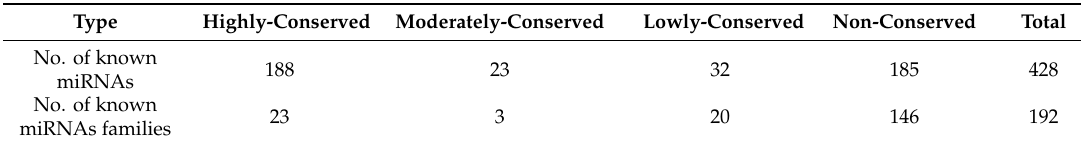
Table 2. MiRNA conservatism grade analysis and